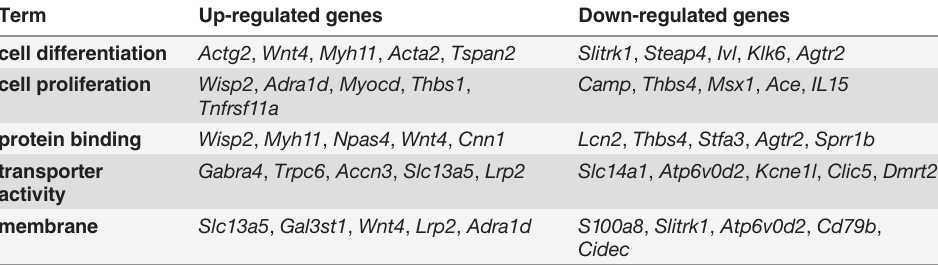
Table 3. Most up-regulated and down-regulated genes involved in important terms about stem